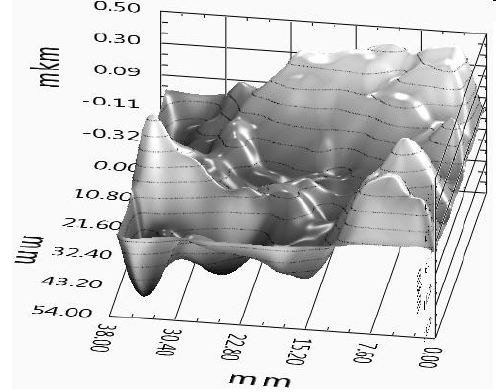
Figure 3. Deformation of a composite of erase cubes filled with epoxy resin (Fig. 1c) when heated in the center at 50°С.